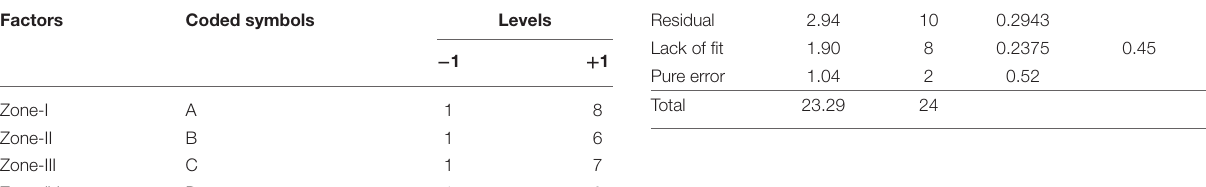
Figure 5 and Table 9 illustrate the summary statistics of the model applied to the variables, which clarifies the significance of both RSM-based